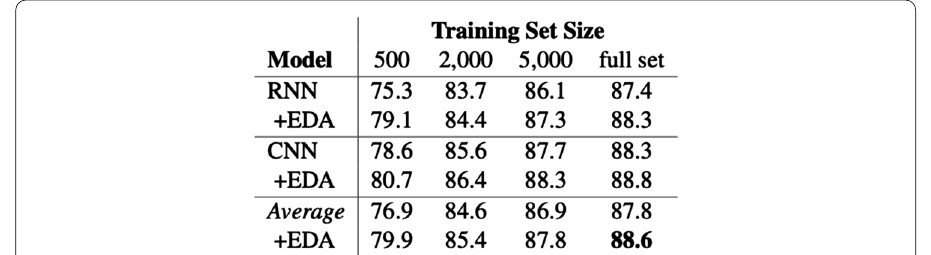
Fig. 1 Success of EDA applied to 5 text classification datasets. A key takeaway from these results is the performance difference with less data. The gain is much more pronounced with 500 labeled examples, compared to 5,000 or the full training